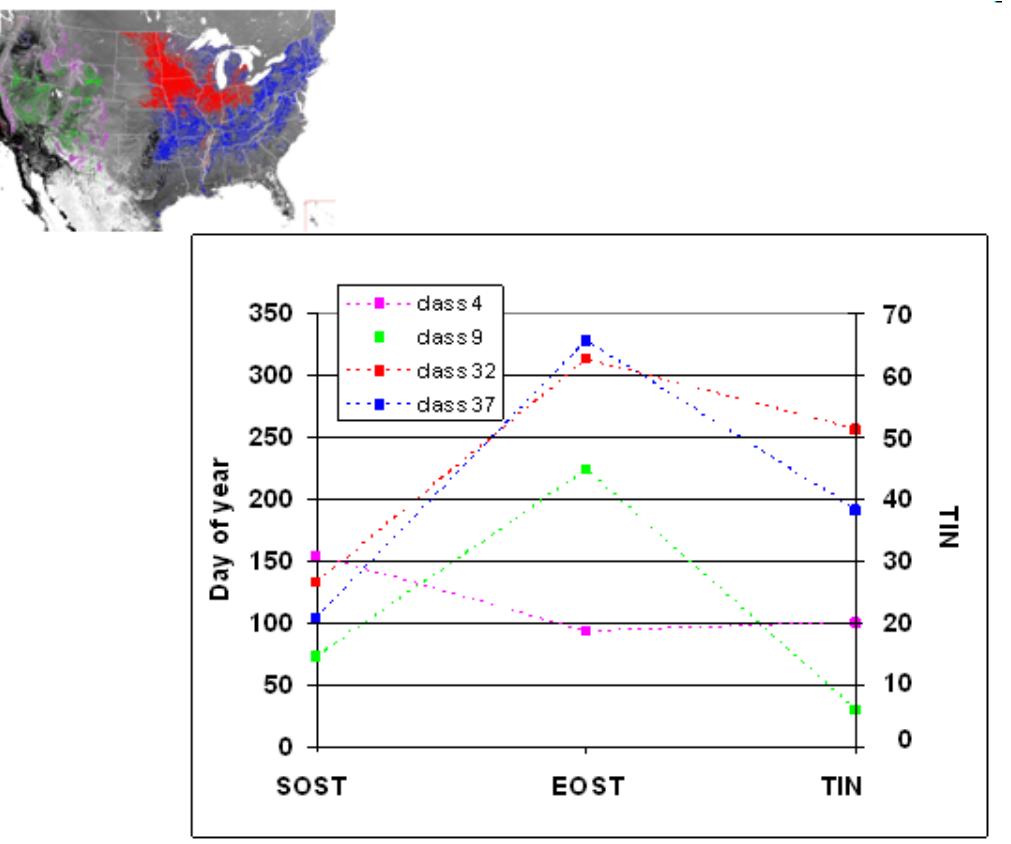
Figure 5. Mean values of SOST, EOST, and TIN for pheno-class 4 (pink, 76% evergreen forest, 14% shrub), pheno-class 9 (green, 83% shrub, 9% grassland), pheno-class 32 (red, 80% cultivated crops), and pheno-class 37 (blue, 46% forest, 20% pasture/hay). The geographic distributions of the locations for each pheno-class are highlighted with the corresponding colors in both